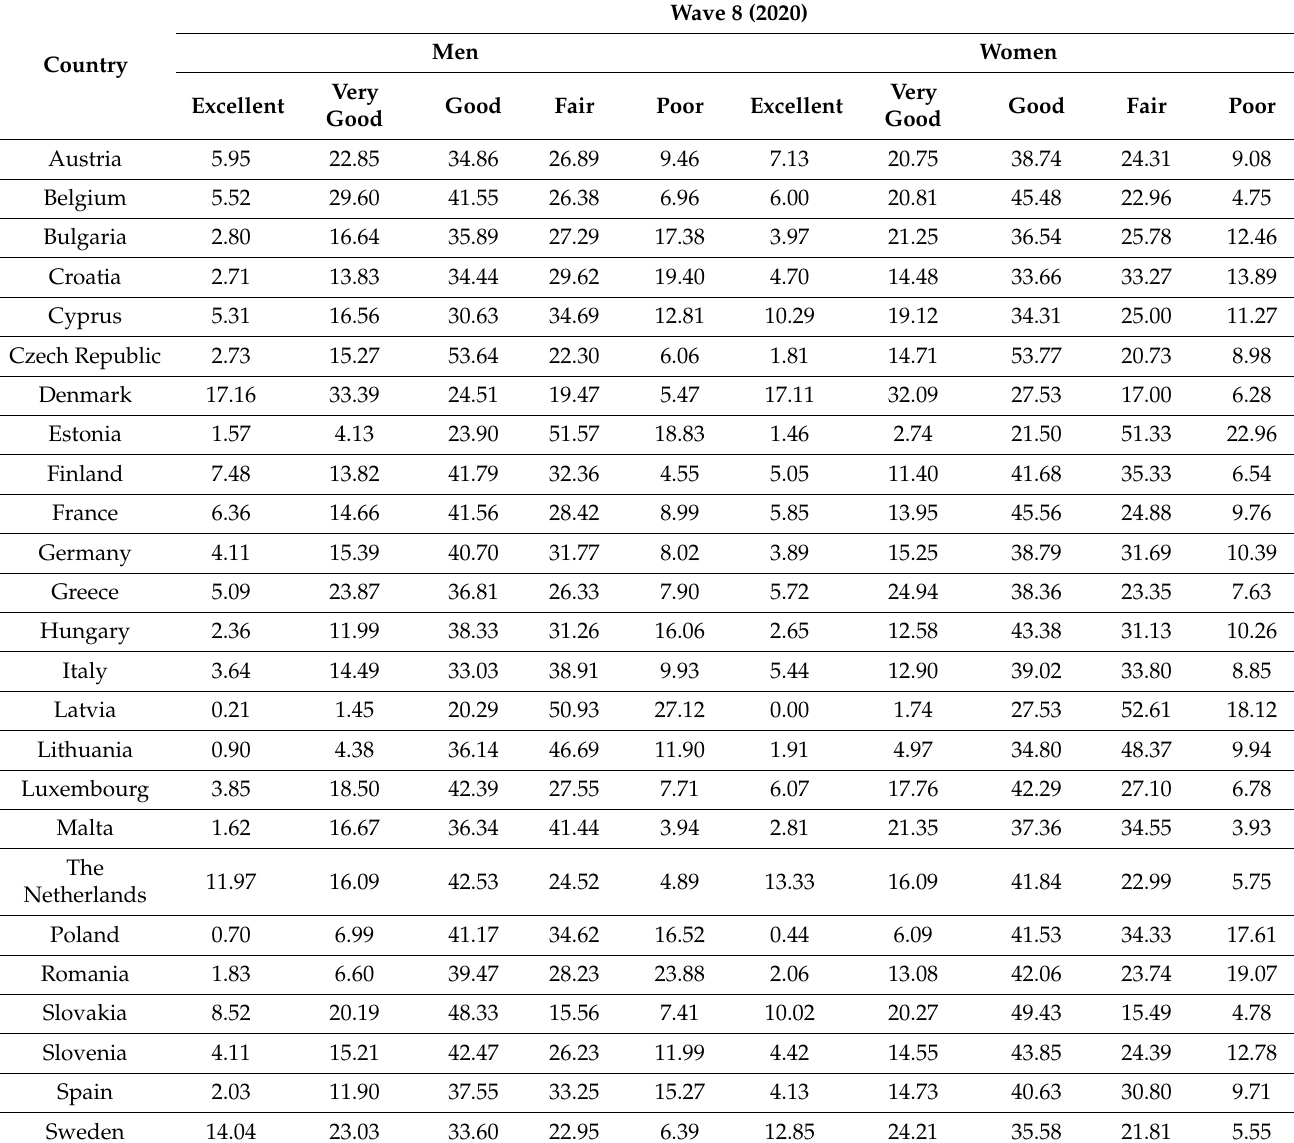
Table 4. Distribution of self-perceived health by gender and country in Wave 8